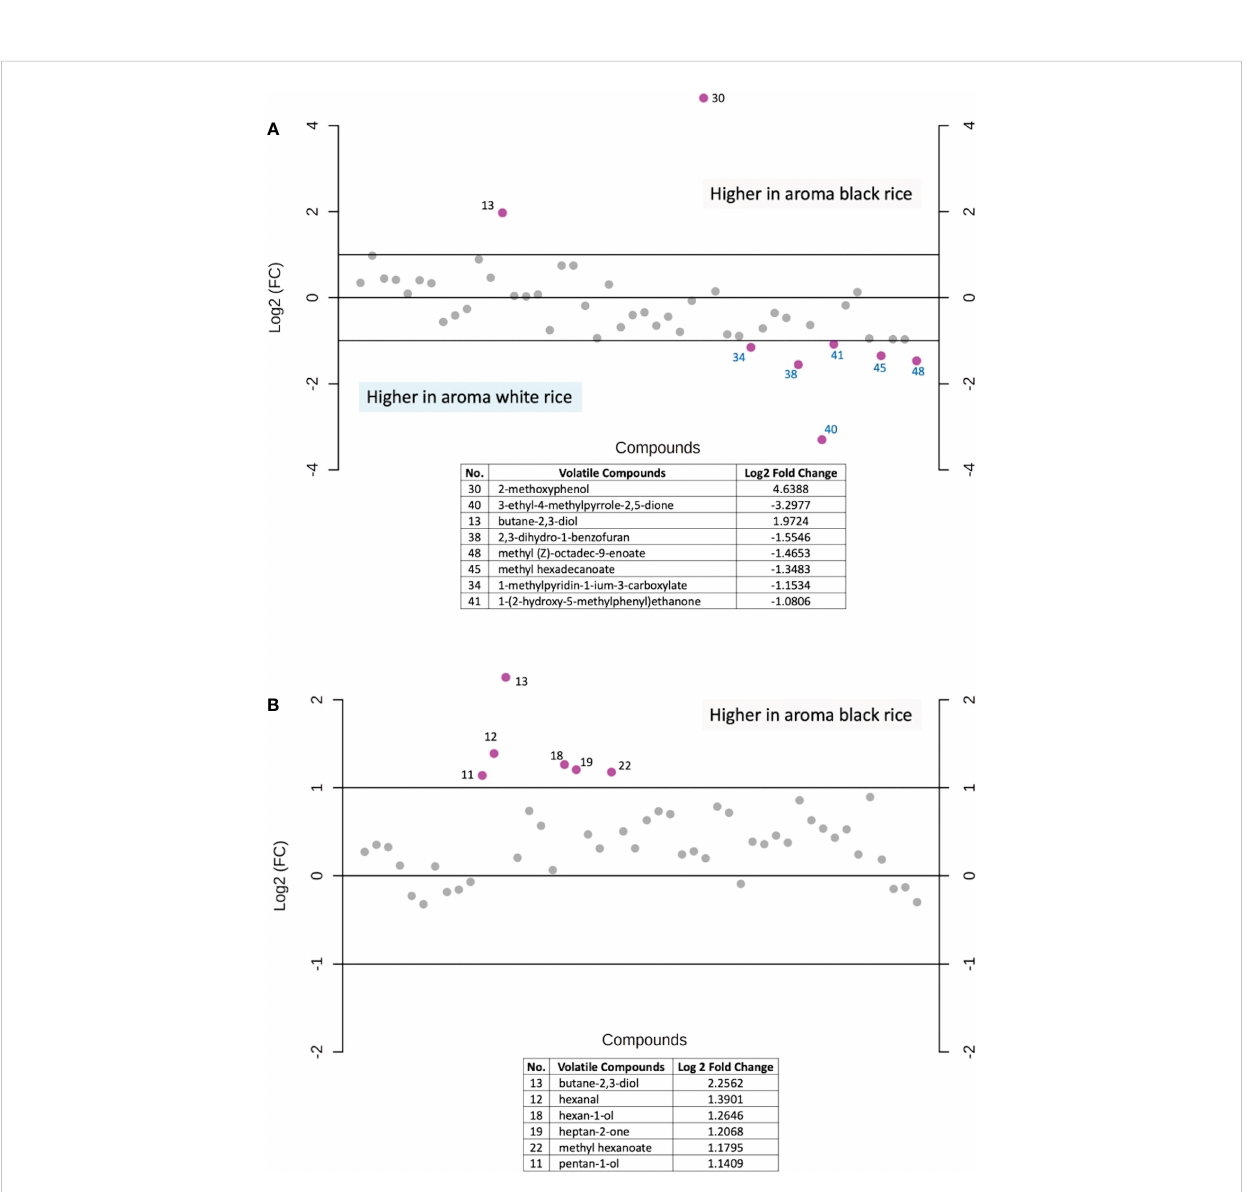
FIGURE 7 Fold-change analysis of the volatile compounds abundance between (A) aromatic black rice and aromatic white rice samples, (B) aromatic black rice and non-aromatic black rice samples. Purple dot represents each rice volatile compounds with a two-fold changes (increase or decrease). Each number represented the identi fi ed volatile compounds arranged by retention